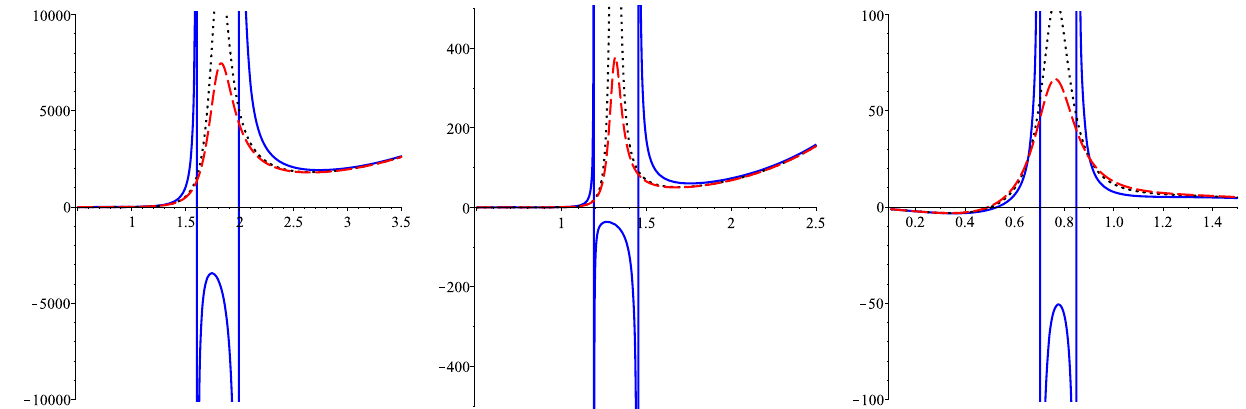
Fig. 15 C P , X versus r + with one divergence point for topological line), c 4 = 6 . 4 (dotted line) and c 4 = 6 (dashed line). Middle panel: i black holes in 7-dimensions. Solid lines display situation related to for k = 0, q = 1, P = 1 / 8 π , m = 1, c 0 = 1, c 1 = 20, c 2 = 10, c 3 = − 10, c 4 = 2 . 4 (solid line), c 4 = 2 . 09 (dotted line) and c 4 = 2 . 04 two divergence points. By decreasing (for k = + 1 , 0) and increasing ( k = − 1) the massive coupling c 4 , two divergence points (see solid (dashed line). Right panel: for k = − 1, q = 1, α = 6 . 7, P = 1 / 8 π , m = 1, c 0 = 1, c 1 = 20, c 2 = 10, c 3 = − 10, c 4 = 2 . 3 (solid line), lines) merge together to form one positive divergence point (see dotted c 4 = 2 . 5 (dotted line) and c 4 = 2 . 6 (dashed line) and dashed lines). Left panel: for k = + 1, q = 1, α = 1, P = 1 / 8 π , m = 0 . 1, c 0 = 1, c 1 = − 10, c 2 = − 10, c 3 = − 10, c 4 = 7 (solid